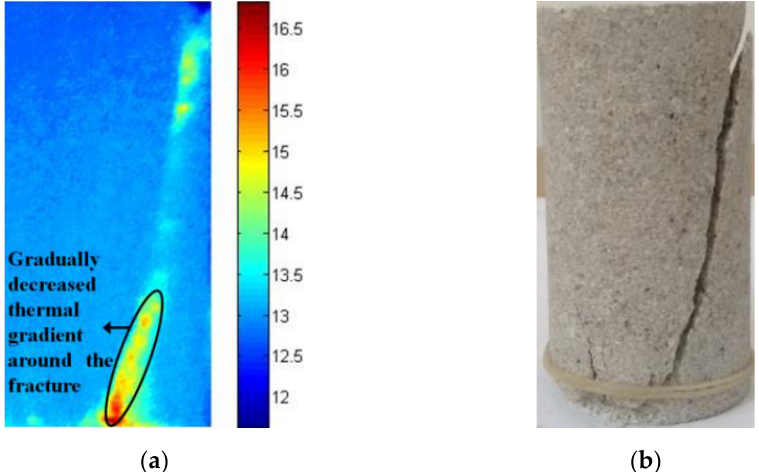
Figure 7. Frictional heating at a shear fracture of sandstone sample A 5. ( a ) Infrared thermal image (°C). ( b ) Object picture.